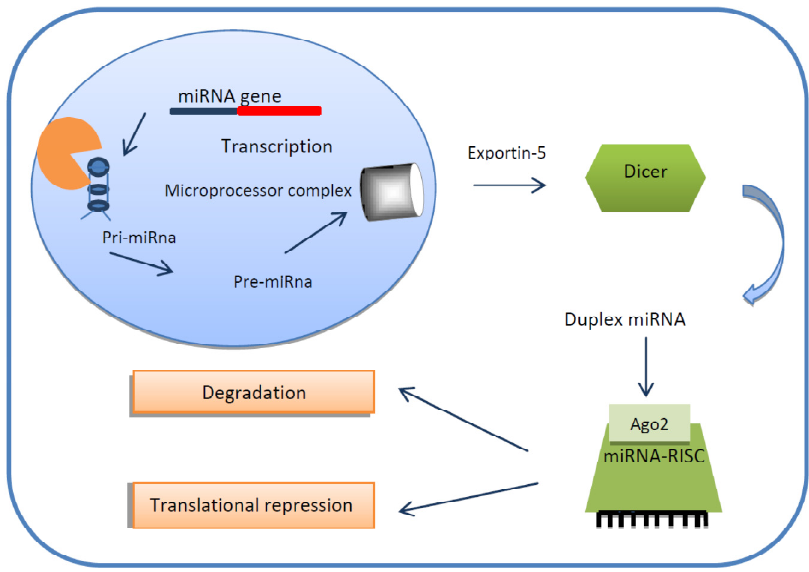
Figure 1. MiRNA biogenesis. MiRNAs genes are transcribed by RNA polymerase into primary miRNAs (pri-miRNA). They are converted into second precursors (pre-miRNA) by the Microprocessor Complex, composed by DiGeorge Syndrome Critical region 8 (DGCR8) and Drosha ribonuclease (RNase III). They are then exported to the cytoplasm by Exportin 5 and are processed into mat ure miRNA/miRNA duplex by DICER enzyme. One of the strands is combined with Argonaute proteins (Ago2) to RNA Induced Silencing Complex (RISC). This complex mediates gene expression by binding target mRNAs and inducing mRNA